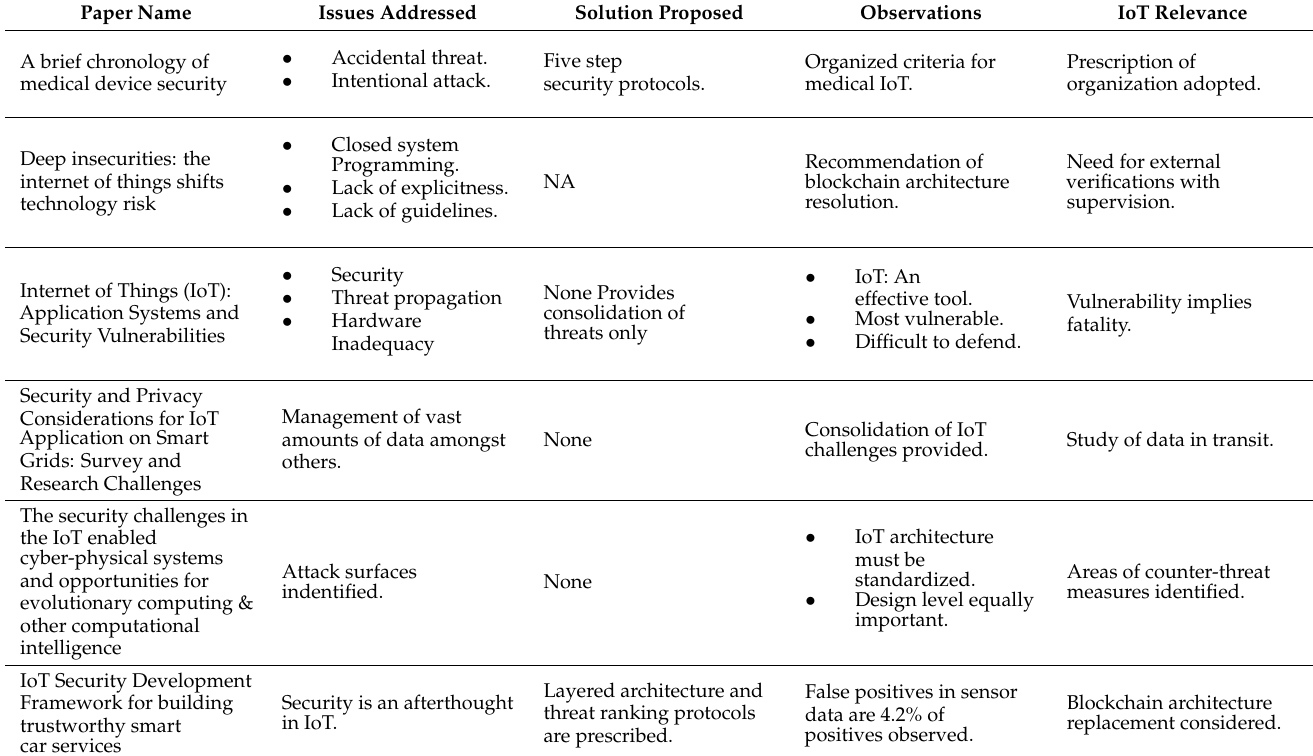
Table 2. Summary of the research pertaining to IoT threats and